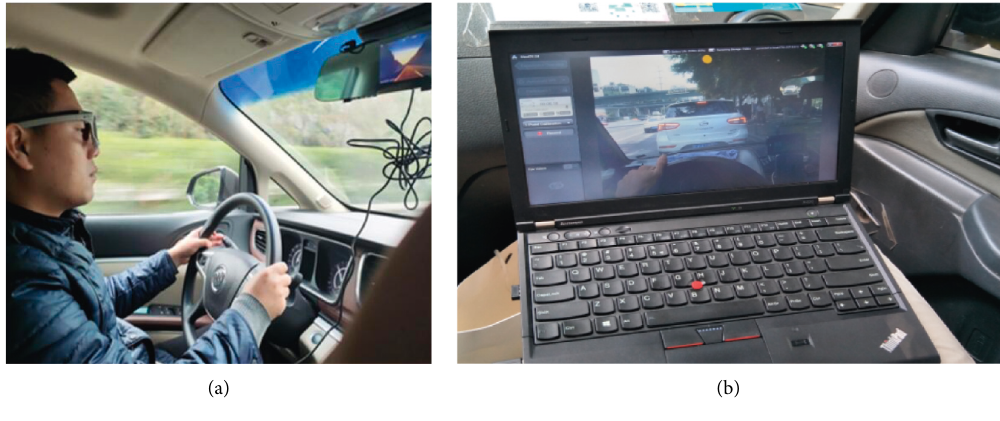
Figure 2: Device of